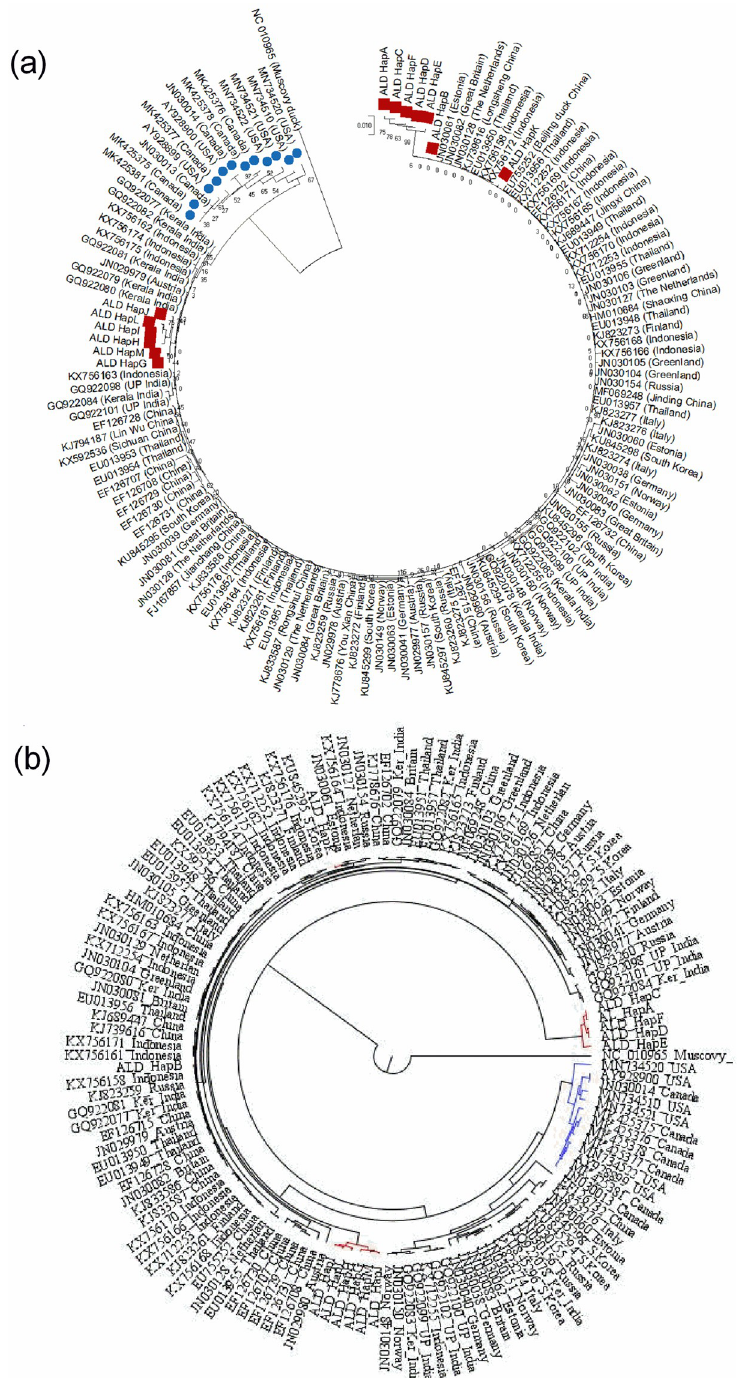
Fig 4. Phylogenetic relationship of ALD with different domestic duck and mallard population of world representing Eurasian clade and North American clade. (a) Neighbor-Joining based phylogenetic tree, (b) Bayesian phylogenetic tree. In N-J phylogenetic tree, sequences representing ’North American clade’ and ALD are presented with blue circles and brown squares respectively. In Bayesian phylogenetic tree, sequences representing ’North American clade’ and ALD are presented with blue and brown lines respectively. The Neighbor-Joining tree was constructed using Tamura-Nei model as implemented in MEGAX following 1,000 bootstrap replications. The Bayesian phylogenetic tree was drawn in BEAST v1.10.4. Muscovy duck (NC_010965) was used as an outgroup.